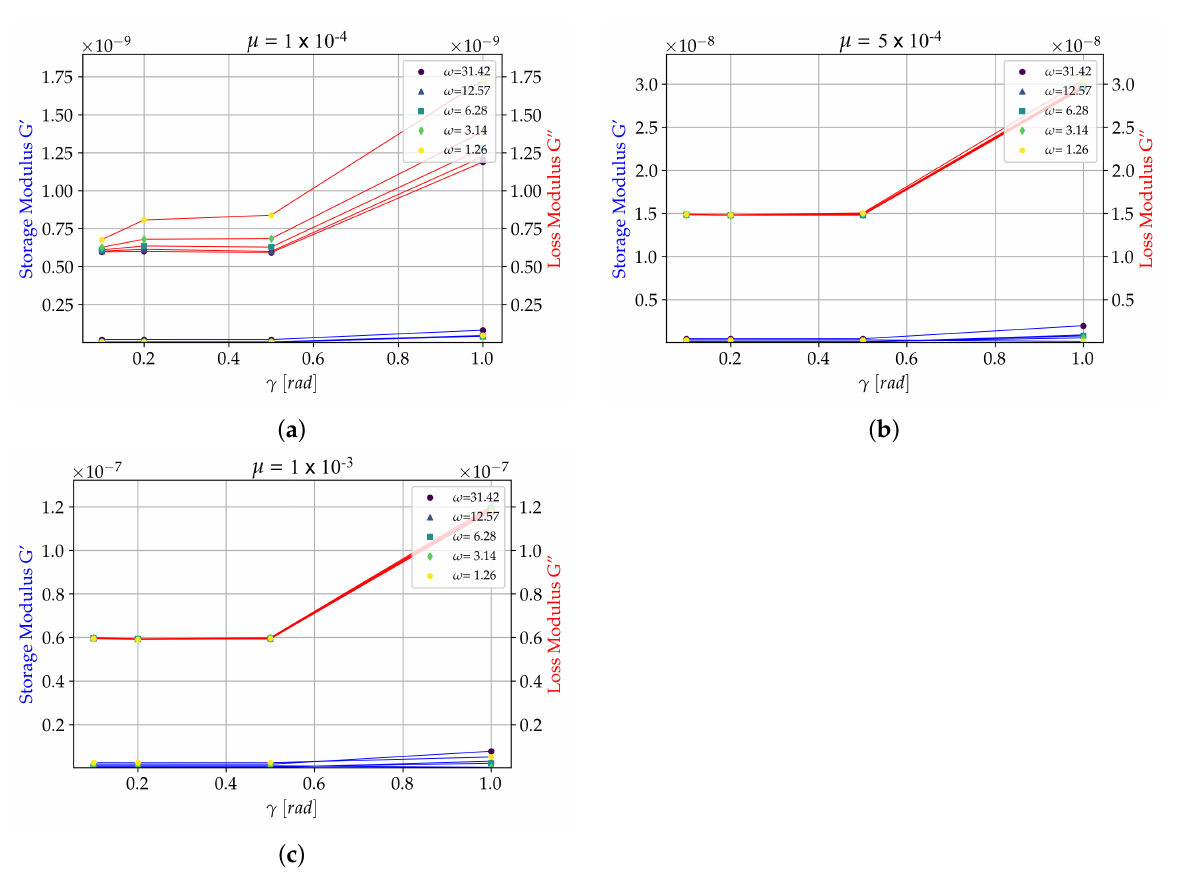
Figure 16. Storage and Loss moduli obtained with an exclusively viscous configuration of the proposed model. Blue: Storage modulus G (cid:48) , red: Loss modulus G (cid:48)(cid:48) . Tests obtained for 1 × 10 − 1 ≤ γ ≤ 1, and for oscillating frequencies ω = 1.26,